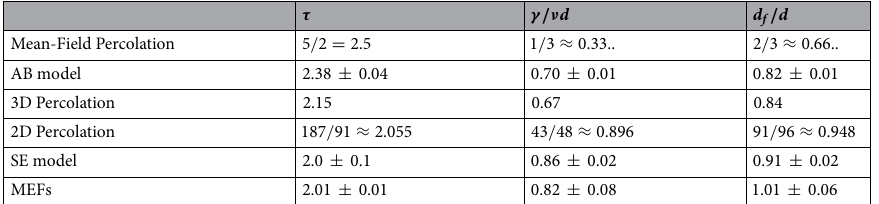
Table 1. Critical exponents determined using models and real mitochondrial networks. The exponents obtained using data from images of mitochondrial networks are more consistent with those of the 2D Percolation universality class. Theoretical exponents were extracted from Ref. 62